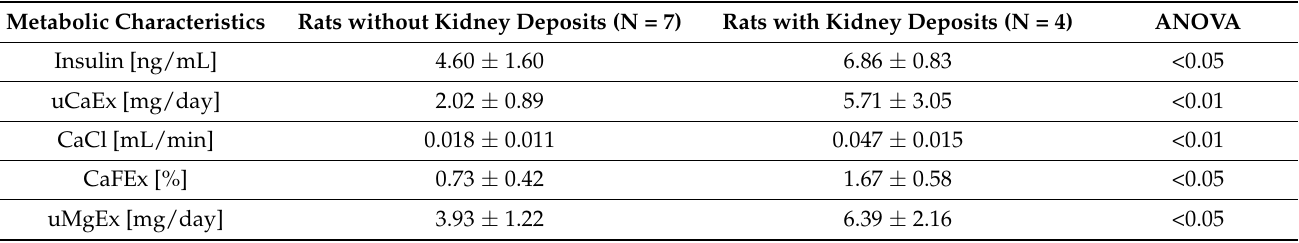
Table 4. Metabolic characteristics of rats on fructose-rich diet (F10 + F60) developing stones versus animals without kidney